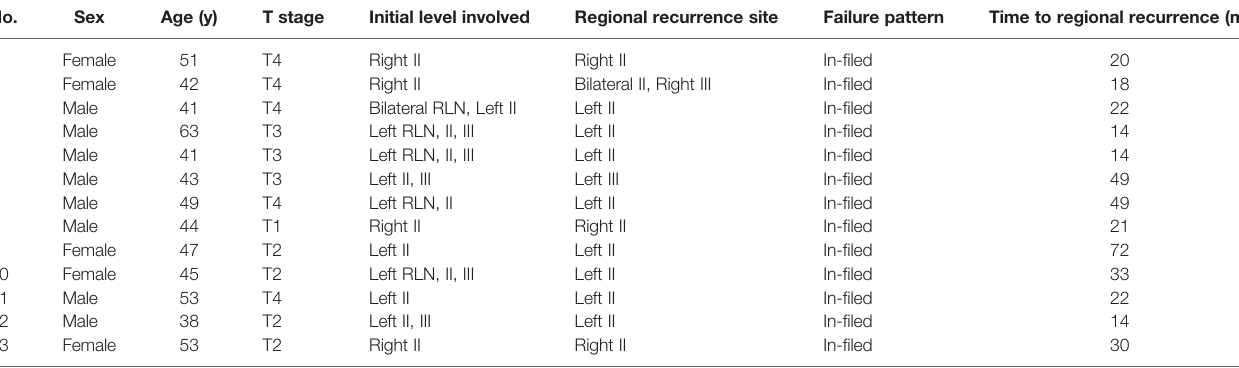
TABLE 3 | Patterns of regional recurrence of the 275 patients with stage N1 nasopharyngeal carcinoma treated by contralateral lower neck sparing radiotherapy (n = 13).